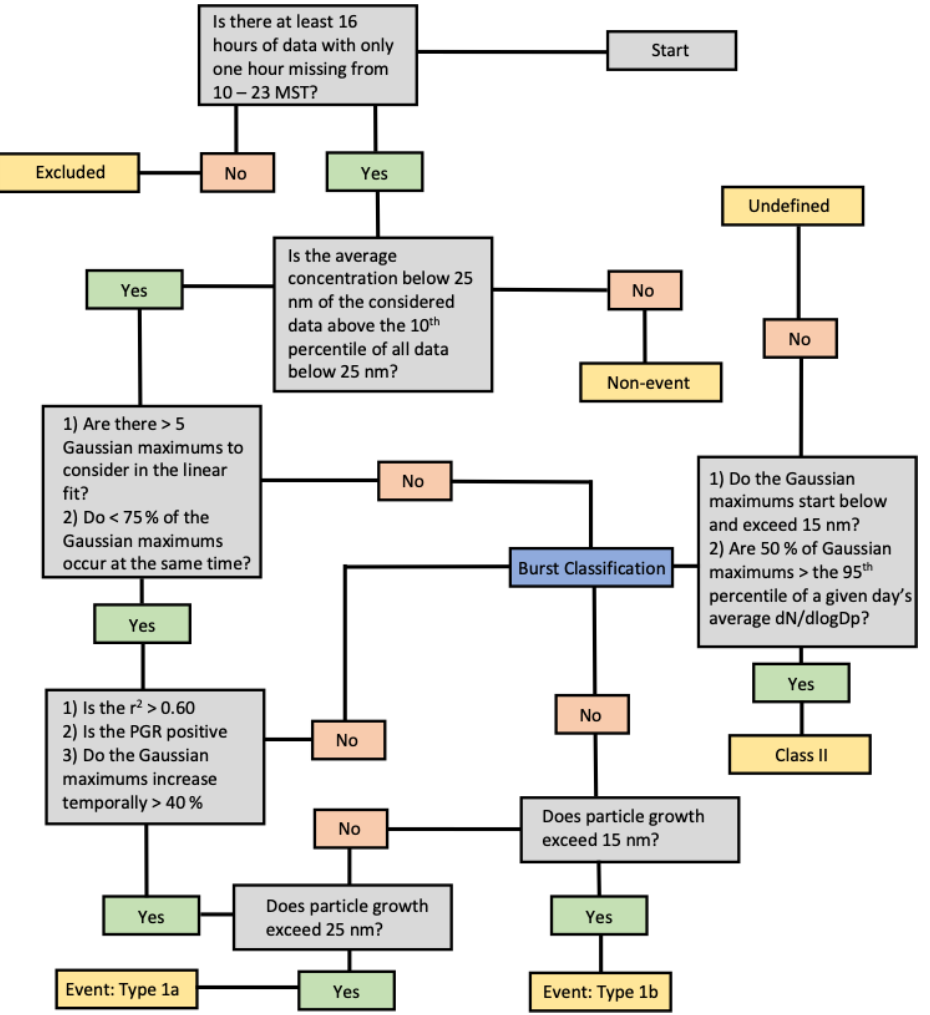
Figure 1. Flowchart illustrating the step-by-step process of the automatic NPF classification method. PGR: particle growth